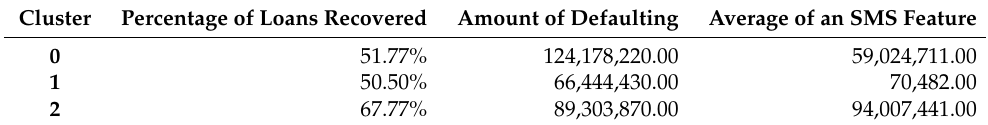
Table 5. Criteria results per each cluster